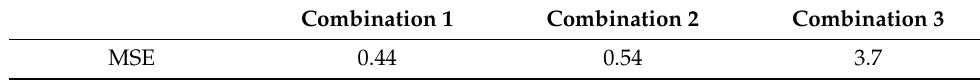
Table 5. Test set MSEs for different input